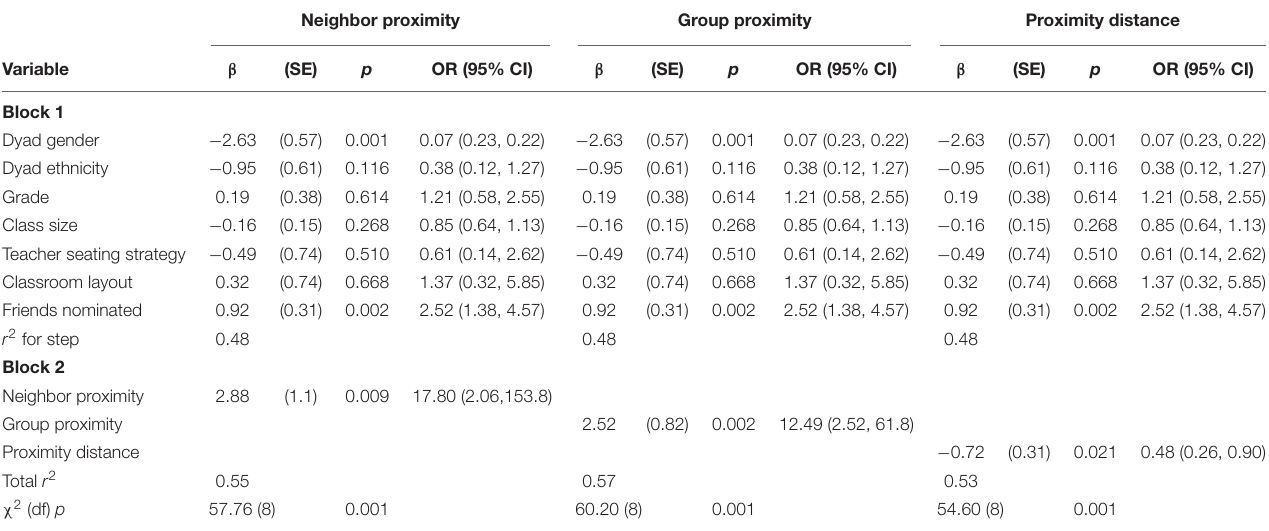
TABLE 2 | Concurrent logistic regressions predicting Time 1 reciprocated friendships from Time 1 classroom seating: One randomly selected dyad per student. Neighbor proximity Group proximity Proximity distance